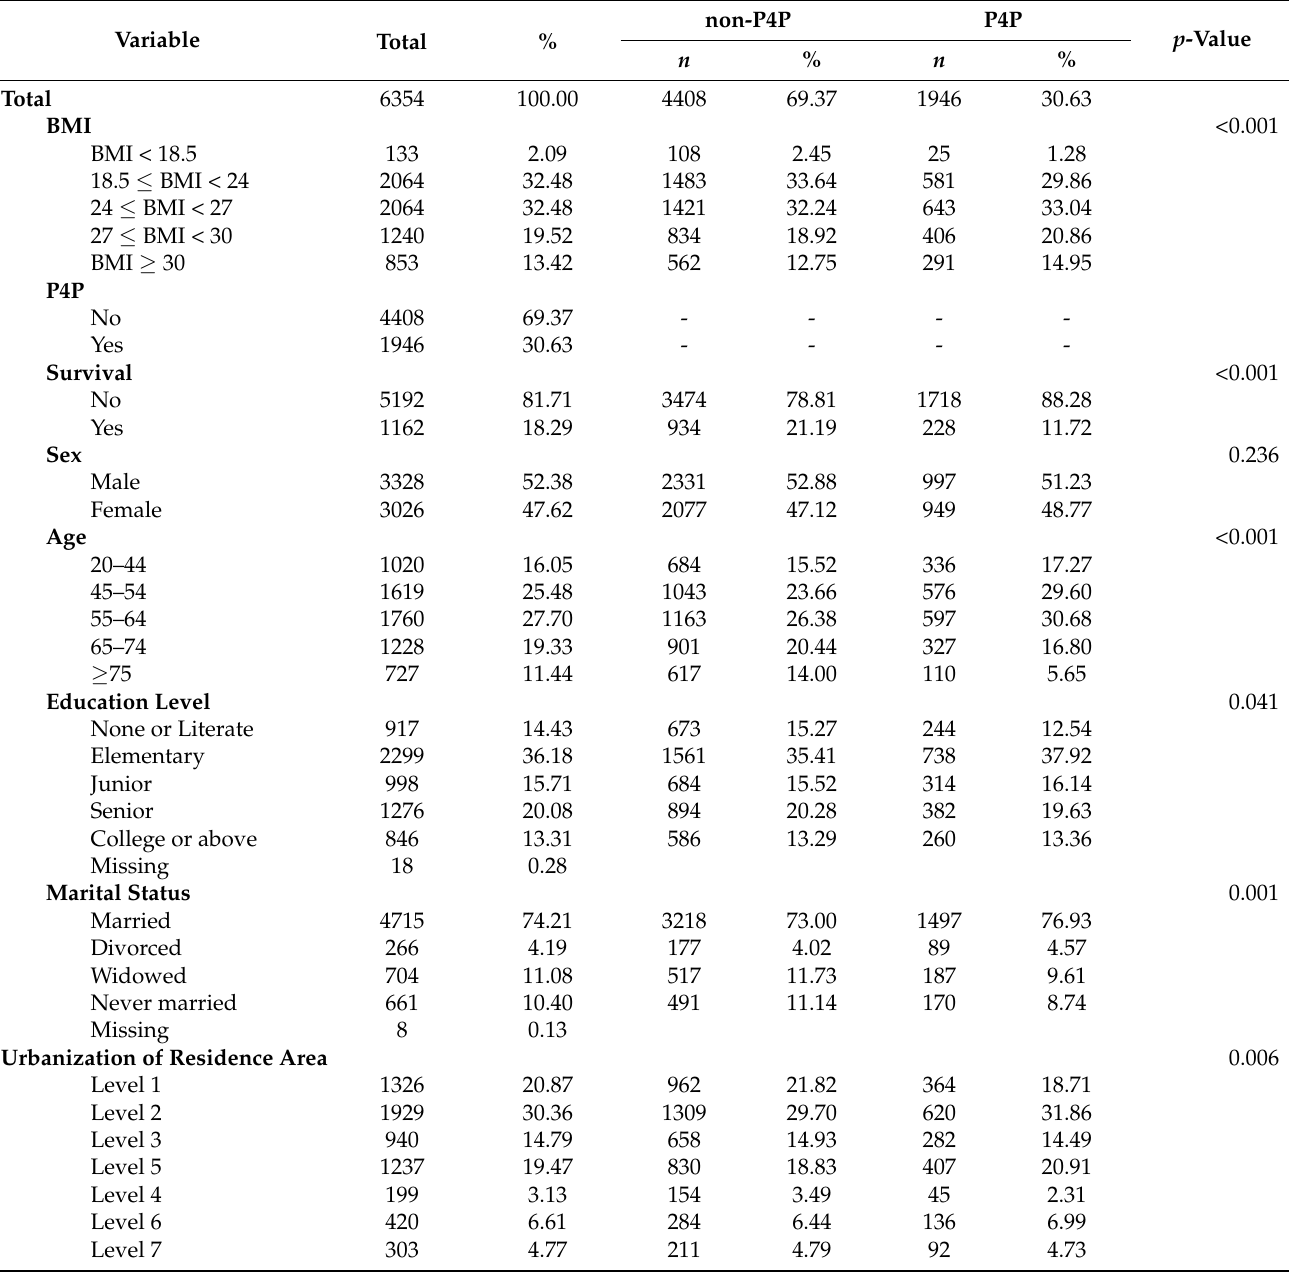
Table 1. The demographic characteristics of patients with type 2